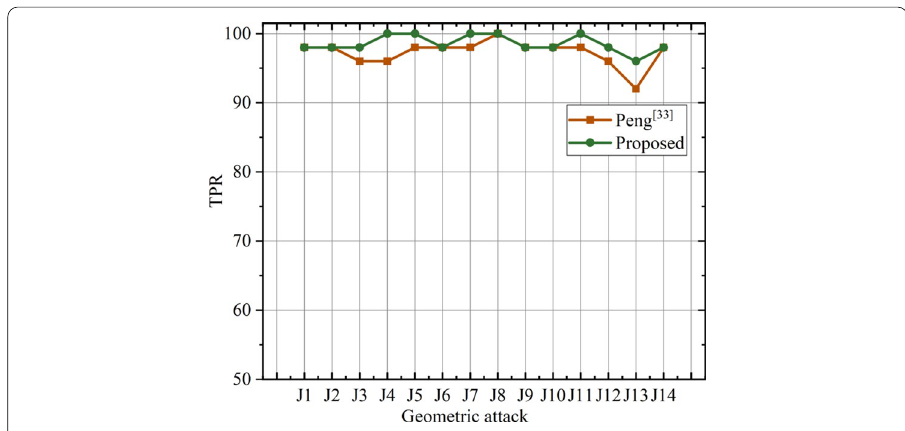
Fig. 11 Robustness comparison on the MICC‑F2000 dataset